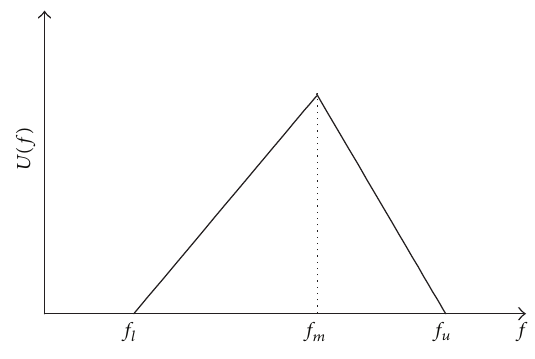
Figure 1: Membership functions of a triangular fuzzy